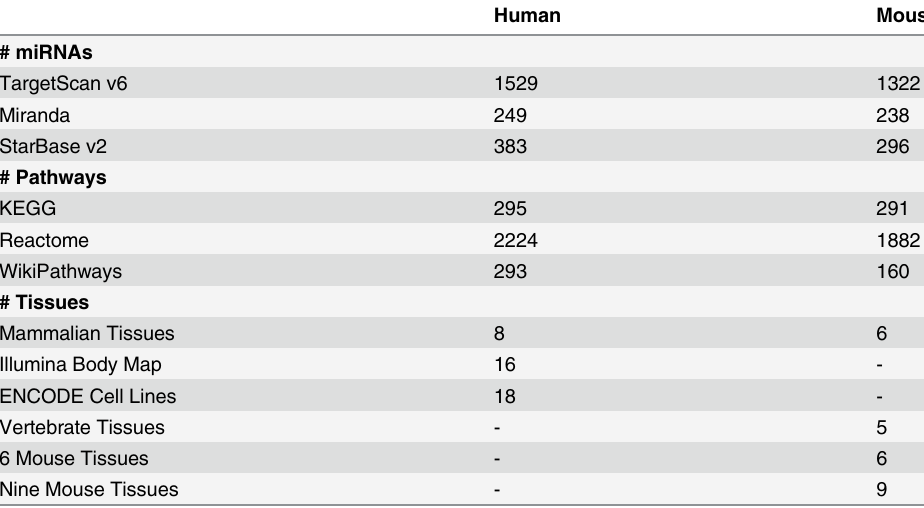
Table 2. Overview of data